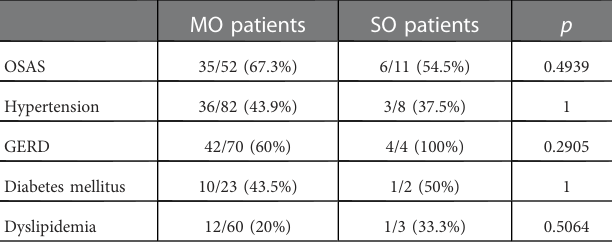
TABLE 4 Partial or complete resolution of comorbidities at 24-month follow-up. MO patients SO patients